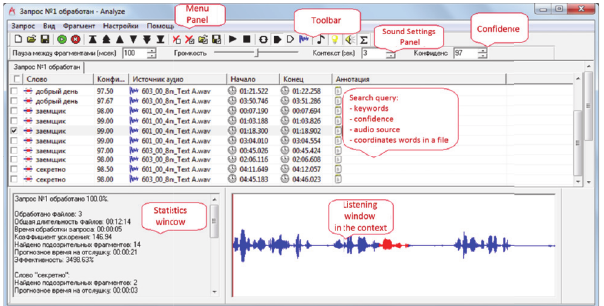
Figure 4: The user interface of the “ANALYZE”